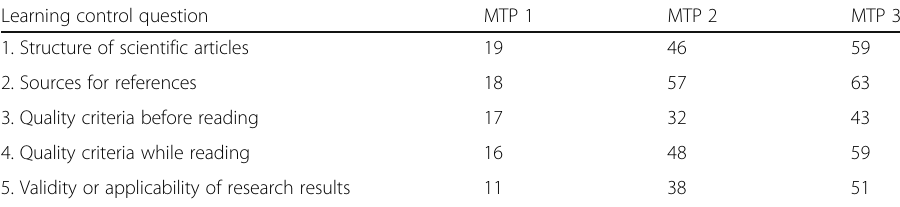
Table 3 Development of the average coverage of the concepts of the model solution at different measurement time points (MTP) for the test group Learning control